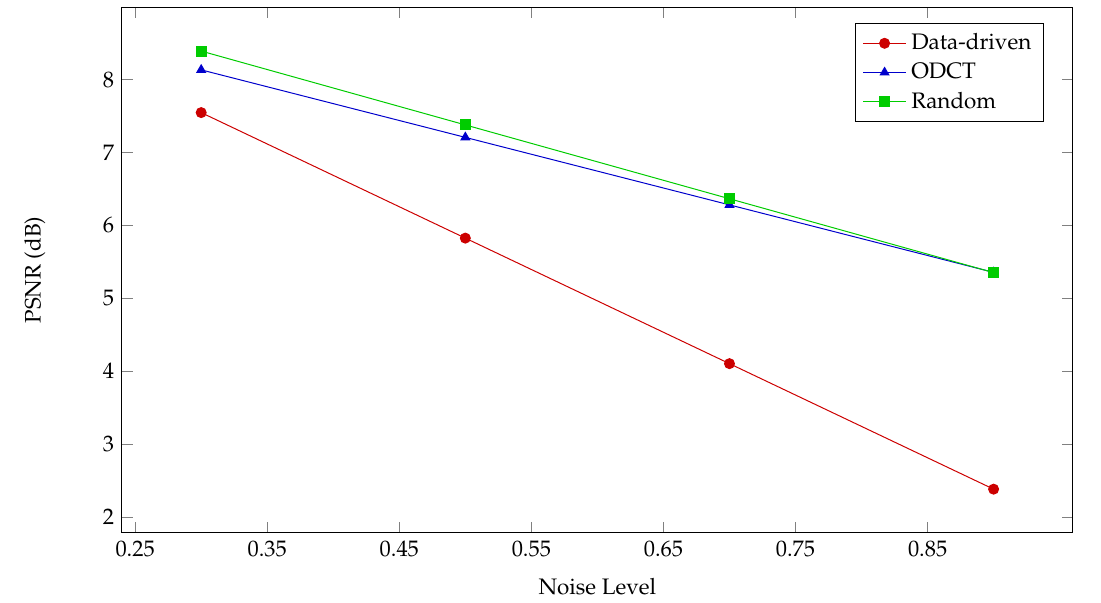
Figure 11. Plot of PSNR (dB) vs. noise level ( ν ) for simulated data using three types of training dictionaries in